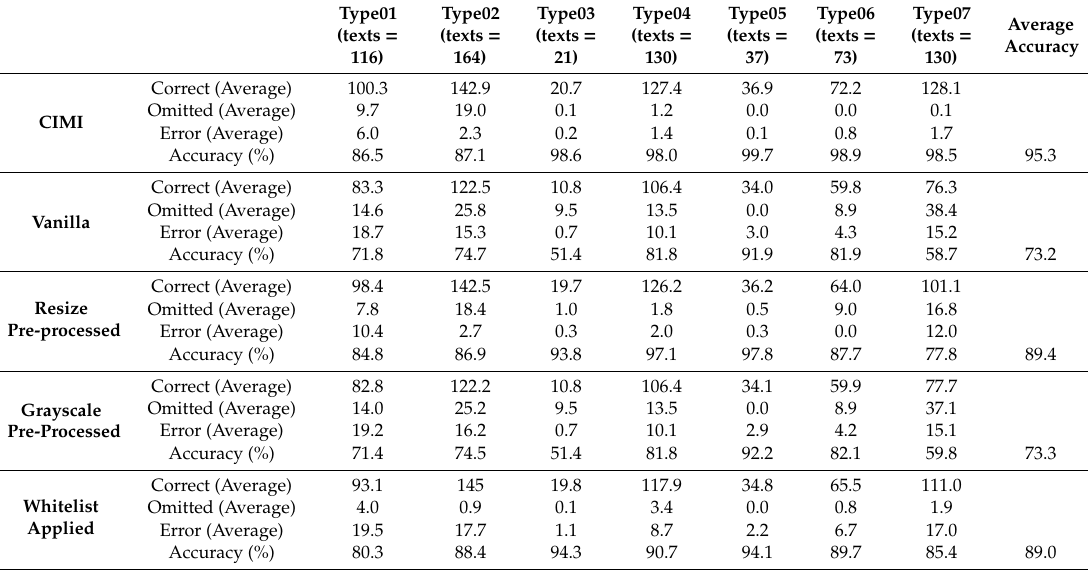
Table 2. Accuracy performance of CIMI and its comparison with other